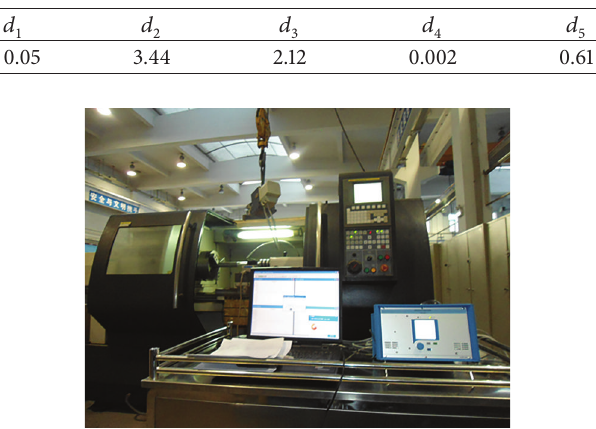
Figure 2: Experimental